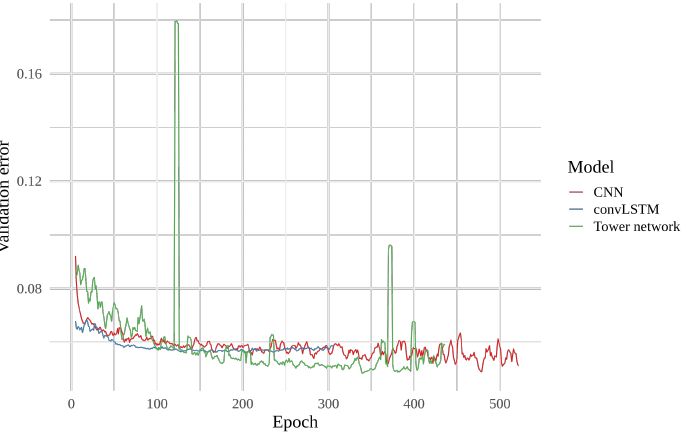
Figure 12. Moving average with a window of 5 of the normalized validation error of each model as a function of number of epochs. Values are averages for the 15 realizations of each model